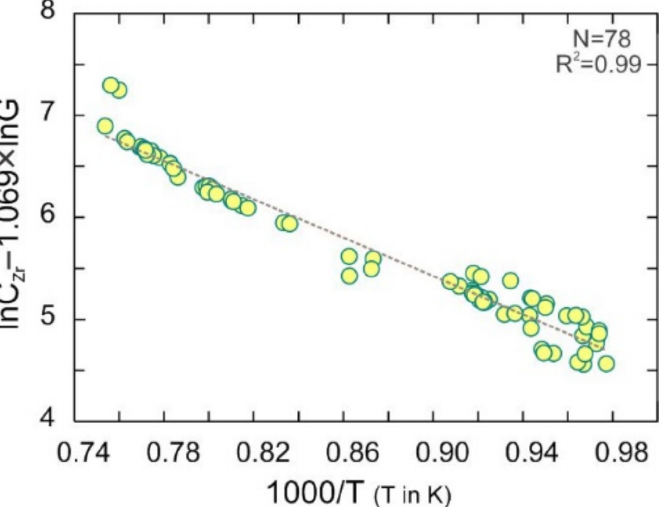
Figure 9. lnC Zr + 1.069lnG vs. 1000/T (T in K) based on Equation (S20-2) for the peralkaline to alkaline rocks.